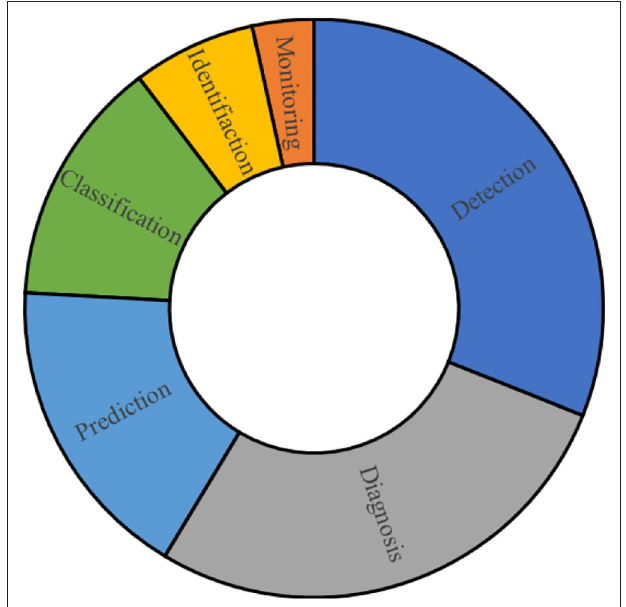
FIGURE 6 | The share of each application type for ML-based systems.